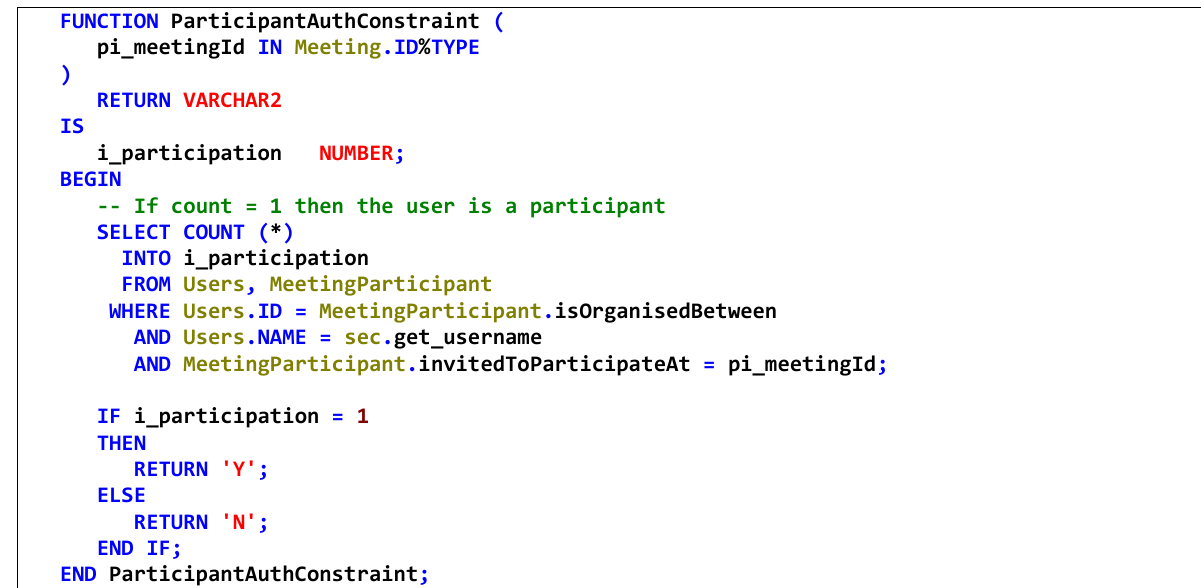
Figure A2. PL/SQL constraint